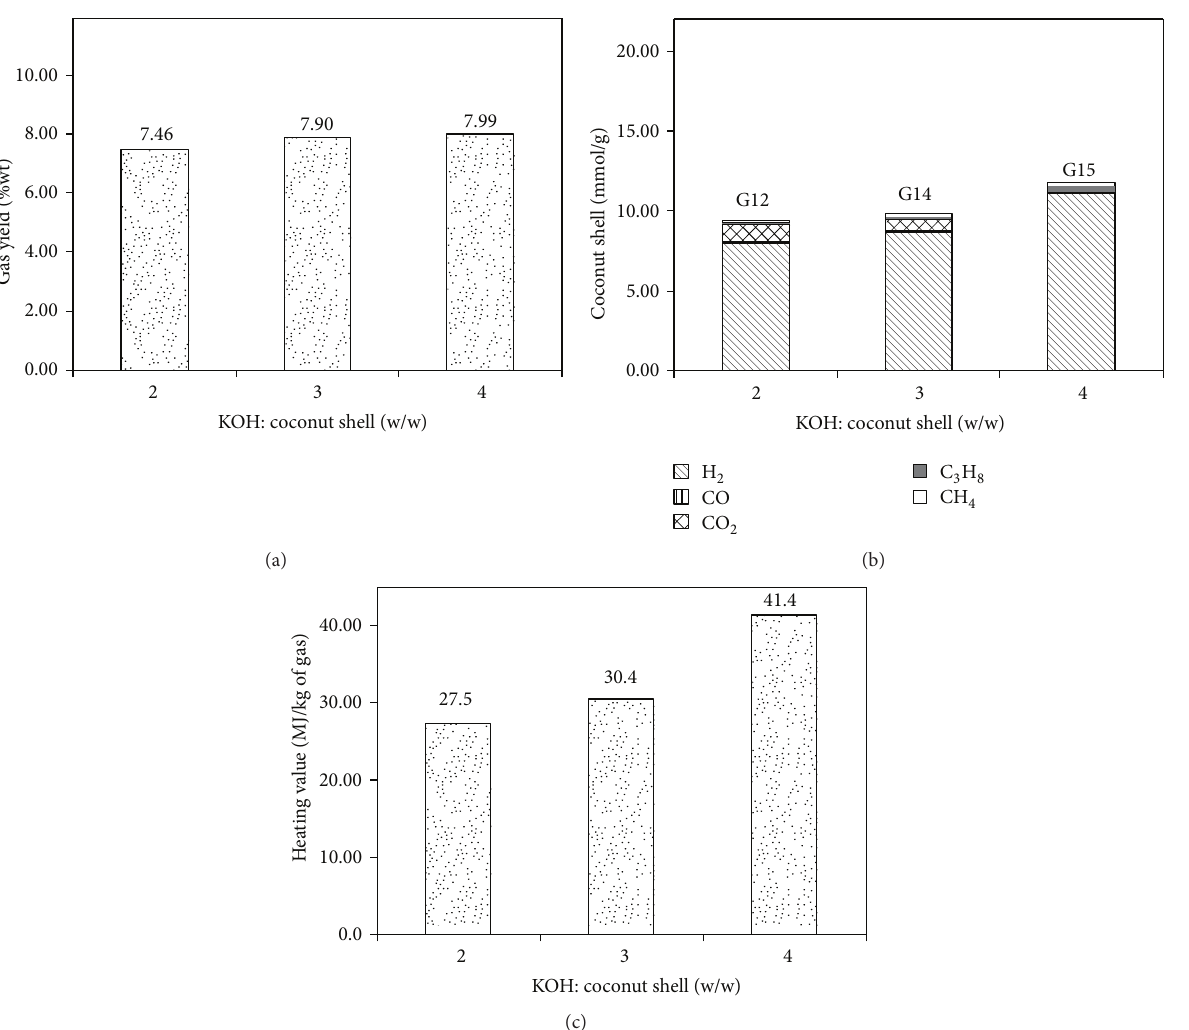
Figure 6: Effect of chemical ratio on gas yield and gas composition from gasification of coconut shell char with carbonization step using 50% CO 2 at 600 ∘ C for 60